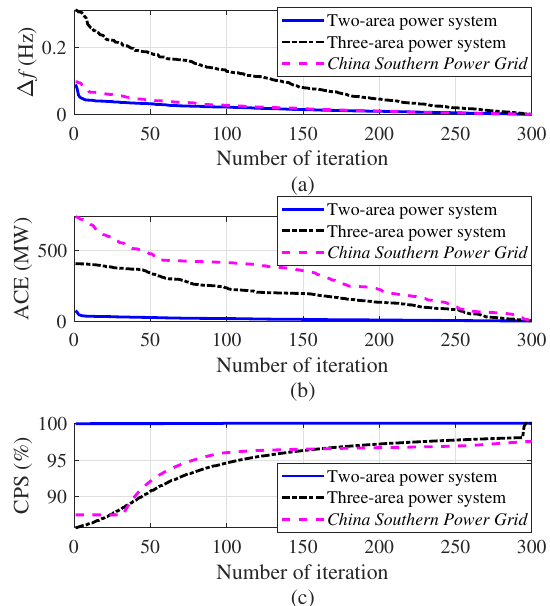
Figure 9. Convergence curves of frequency deviation, area control error (ACE), and control performance standard (CPS) of the training process of deep forest reinforcement learning (DFRL): ( a ) frequency deviation; ( b ) ACE; ( c ) CPS.